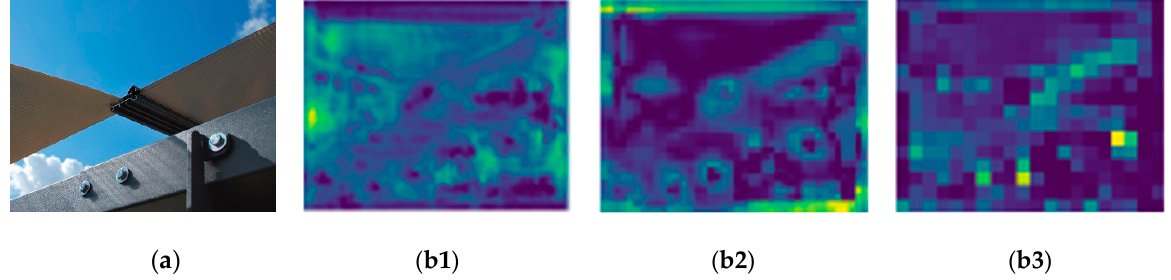
Figure 4. Visual feature maps of three output layers: ( a ) original image; ( b1 ) 19*19 feature map; ( b2 ) 38*38 feature map; ( b3 ) 76*76 feature map. ( b2 ) 38*38 feature map; ( b3 ) 76*76 feature